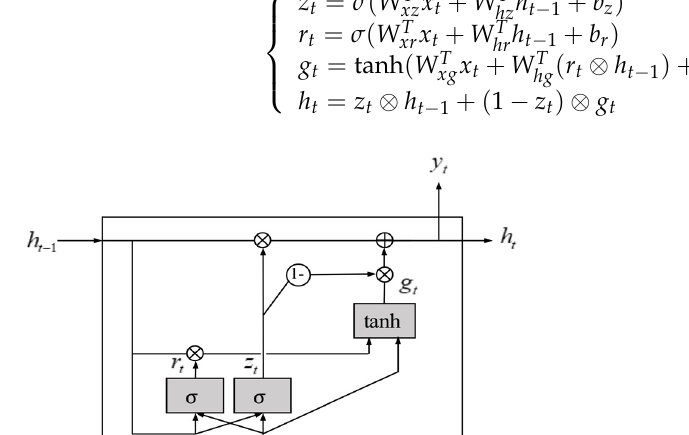
Figure 11. A GRU unit.